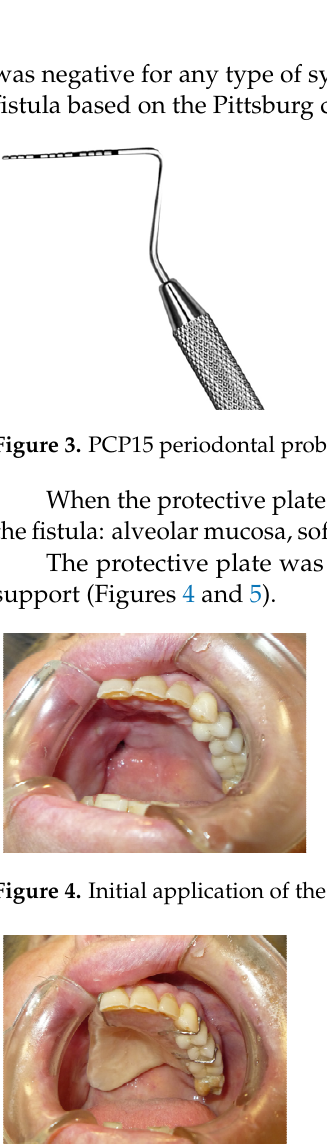
Figure 7. After one month. 3.1.2. Case 2: P.S. A 19-year-old female patient with a previous palatal carcinoma. The patient was being treated with Metformin for type 2 diabetes. She reported only an allergy to penicillin. She was referred to our department after the removal of a type II palatal fistula carcinoma according to the Pittsburg classification (Figure 8). The patient had all the